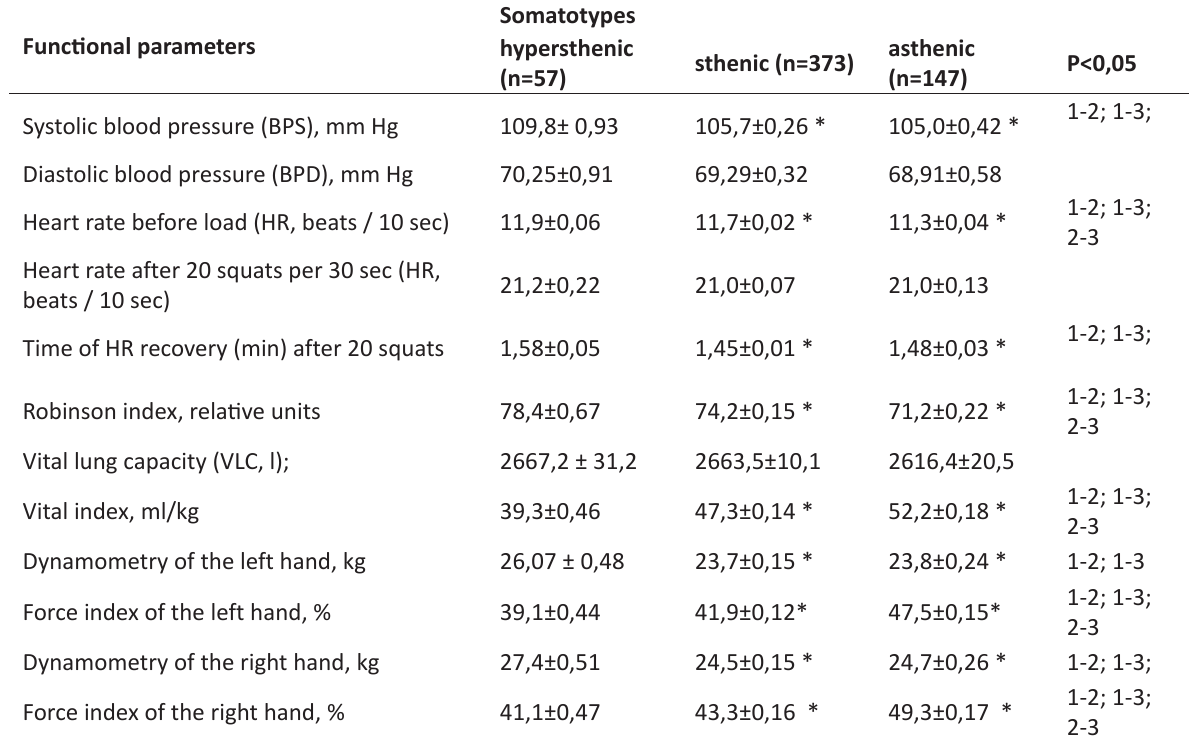
Table 2. The characteristic of functional parameters in girl-students of different somatotypes (M±m) Functional